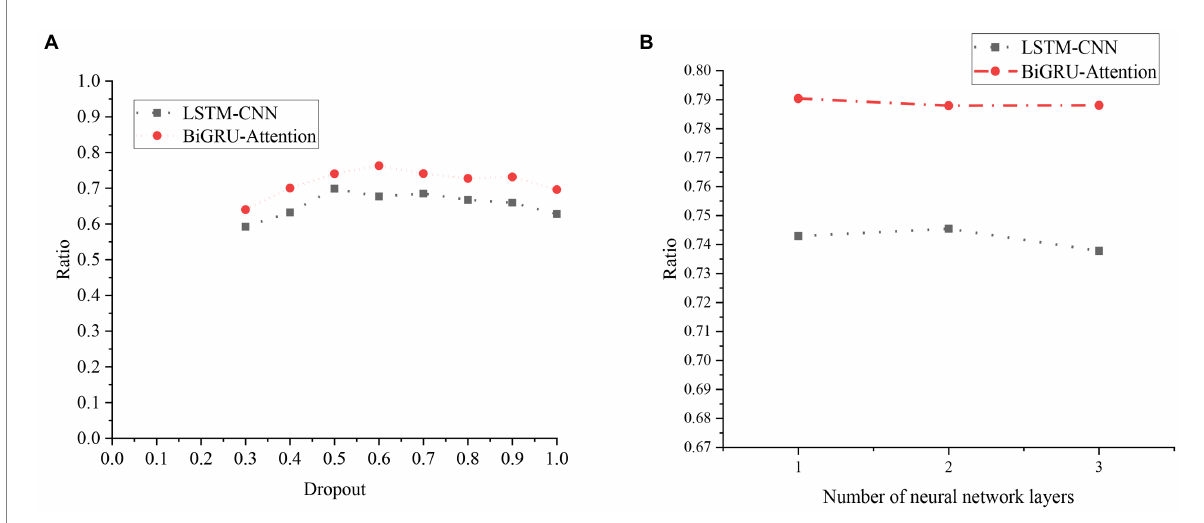
FIGURE 20 Experimental results of the LSTM model and the BiGRU-Attention model with different parameters. (A) Experimental results of different Dropout parameters. (B) Experimental results of different NN